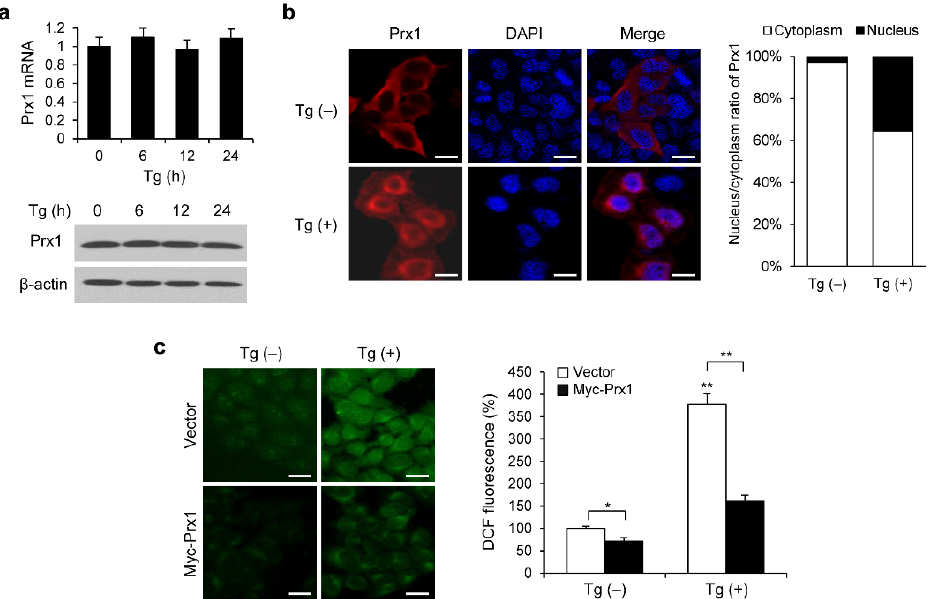
Figure 4. Prx1 overexpression inhibits ER stress ‐ induced ROS production. ( a ) qRT ‐ PCR and WB were performed to detect PRDX1 mRNA and protein expression levels in HEK293 cells treated with 300 nM Tg. ( b ) Immunofluorescence of HeLa cells treated with 300 nM Tg for 12 h. Scale bar, 20 μ m. The ratio (%) of the average intensities of the Prx1 signals in the nucleus and cytoplasm was determined using ImageJ software. ( c ) DCF ‐ DA staining of HeLa cells with control vector or Myc ‐ Prx1 exposed to 300 nM Tg for 12 h. The DCF fluorescence intensity was assessed using ImageJ software. Scale bar, 20 μ m. Data are expressed as the mean ± SD of three independent experiments (* p < 0.05 and ** p < 0.01).